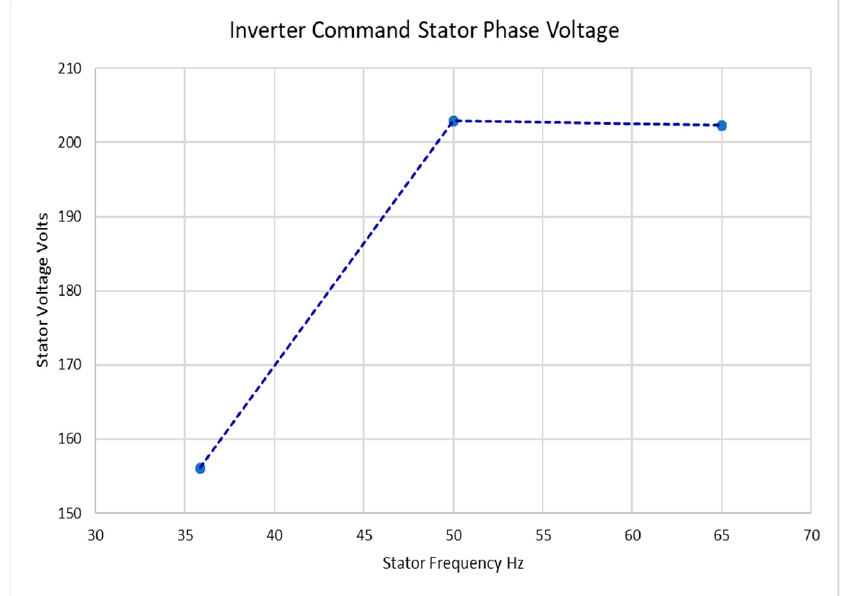
Figure 15. Stator Voltage vs. stator frequency of IM.